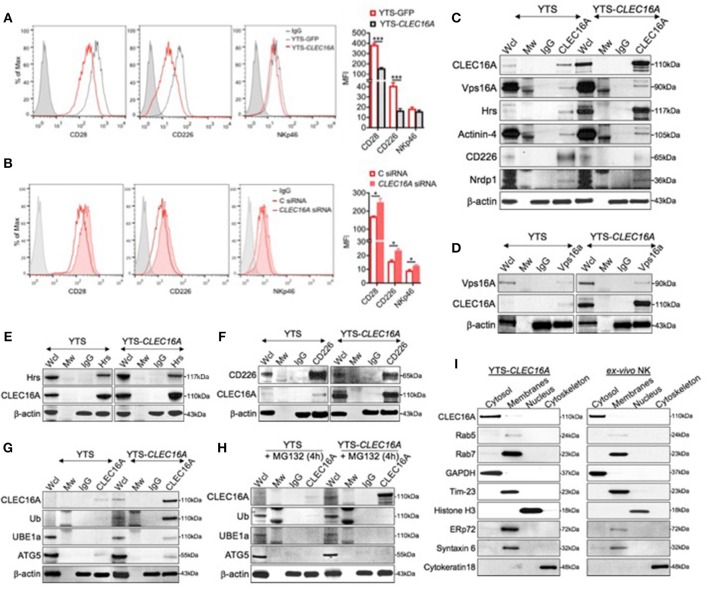
CLEC16A interacts with the class C Vps-HOPS complex, modulates NK cell surface markers expression and depicts cytosolic localization. (A) Representative histogram (left) and mean fluorescent intensities (MFI) of cell surface receptor CD28, CD226, and NKp46 in Clec16a overexpressing cells and YTS-GFP control (n = 3 repeats) by flow cytometry analysis. (B) Reversal of receptor expression in siRNA mediated CLEC16A knockdown. Representative histogram (left) depicts percentage decrease in expression of CD28, CD226, and NKp46 in control and CLEC16A siRNA nucleofected cells. MFI graph (right) depicts increase in expression of CD28, CD226, and NKp46 in YTS-CLEC16A overexpressing cells and YTS-GFP control (n = 3 repeats). *P < 0.05, ***P < 0.001 (unpaired two-tailed Student's t-test). (C) CLEC16A IP-pull down and representative immunoblot analysis of CLEC16A, Vps16A, Hrs, Actinin-4, and CD226 and Nrdp1. Membranes were stripped and re-probed for β-actin as a loading control (bottom). (D) Representative reverse IP-pull down and immunoblot of VPS16A and CLEC16A in YTS and YTS-CLEC16A. (E) Representative reverse IP-pull down and immunoblot of Hrs and CLEC16A in YTS and YTS-CLEC16A. (F) Representative reverse IP-pull down and immunoblot of Hrs and CLEC16A in YTS and YTS-CLEC16A. (G) Representative CLEC16A IP-pull down and immunoblot of CLEC16A, Ub, UBE1a, and ATG5 in YTS and YTS-CLEC16A. (H) Representative CLEC16A IP-pull down and immunoblot of CLEC16A, Ub, UBE1a, and ATG5 in YTS and YTS-CLEC16A cells pretreated with proteasomal inhibitor MG132. Membranes were stripped and re-probed for β-actin as a loading control for all pull down experiments (bottom). (I) Representative immunoblot depicting cytosolic localization of CLEC16A in YTS-CLEC16A and ex vivo NK cell fractioned lysates. Membranes were stripped and probed for GAPDH as loading control for cytosolic fraction, Rab5 (early endosomes marker), Rab7 (late endosomes marker), Tim-23 (mitochondrial membrane fraction), Histone H3 (Nucleus), ERp72 (endoplasmic reticulum (ER), Syntaxin 6 (Golgi), and Cytokeratin 18 (cytoskeleton loading control).